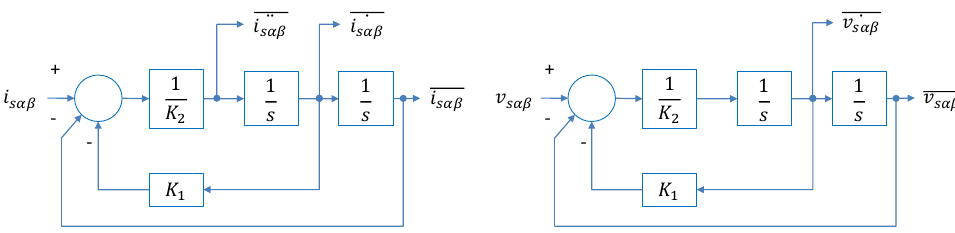
Figure 1. Filtering for extracting the electrical variables and its derivatives through